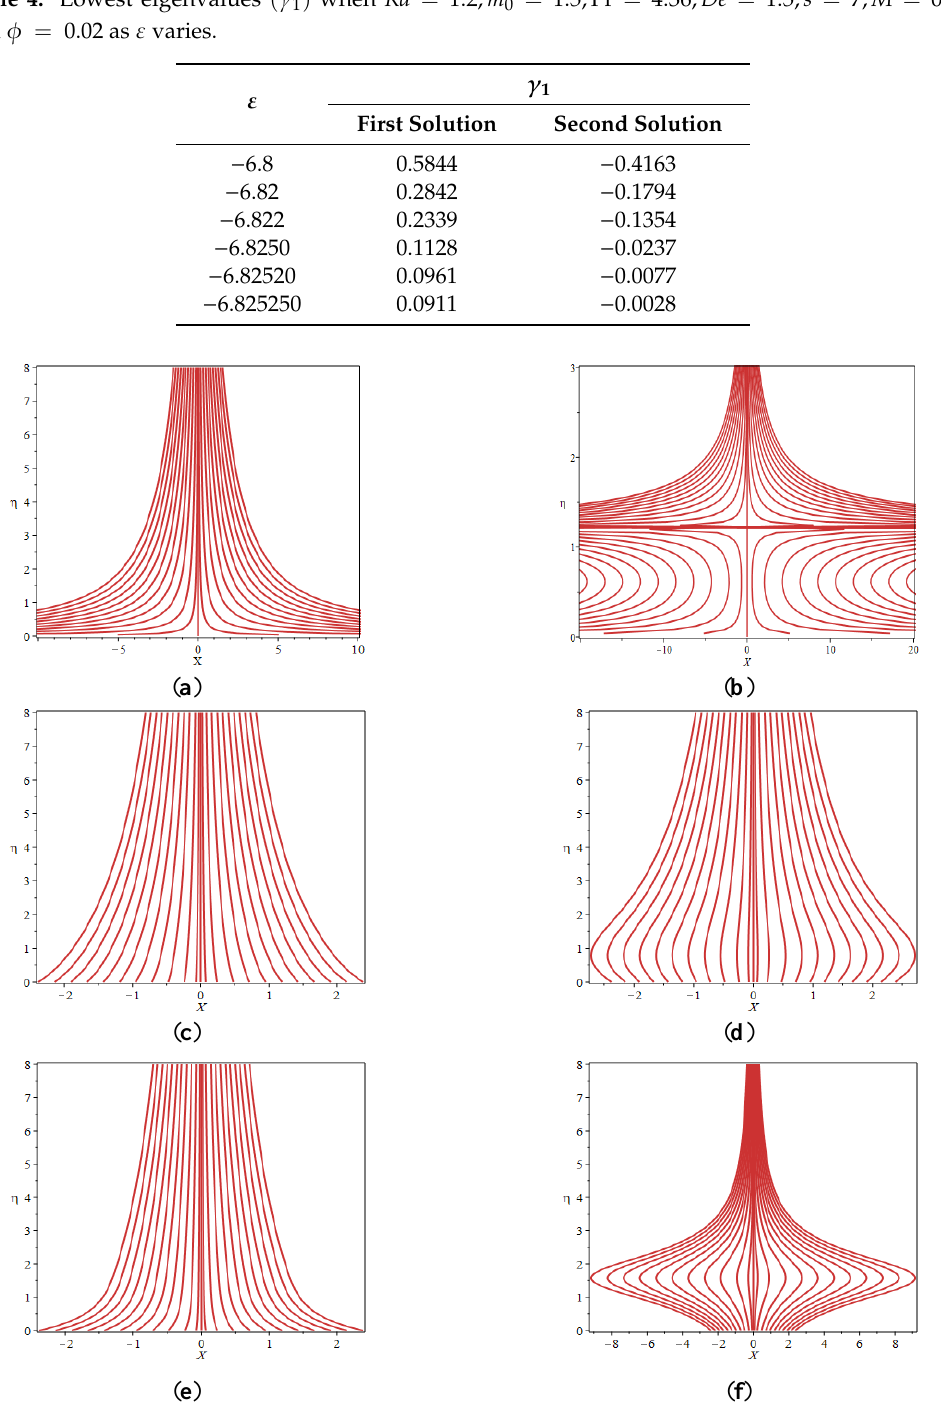
Table 4. Lowest eigenvalues ( γ 1 ) when Rd = 1.2, m 0 = 1.5,Pr = 4.36, De = 1.5, s = 7, M = 0.5, and φ = 0.02 as ε varies.